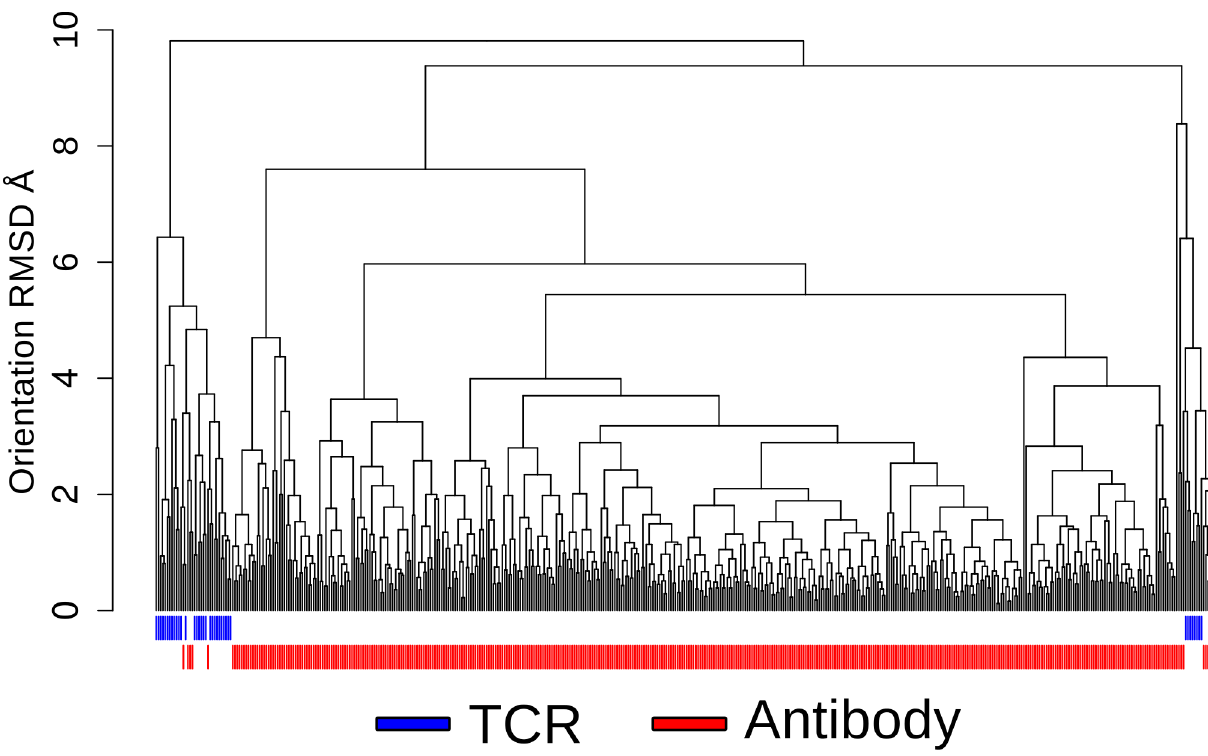
Figure 2. Clustering of the antibody and TCR structures by their relative orientation RMSD. The two types of structure fall largely into different clusters.